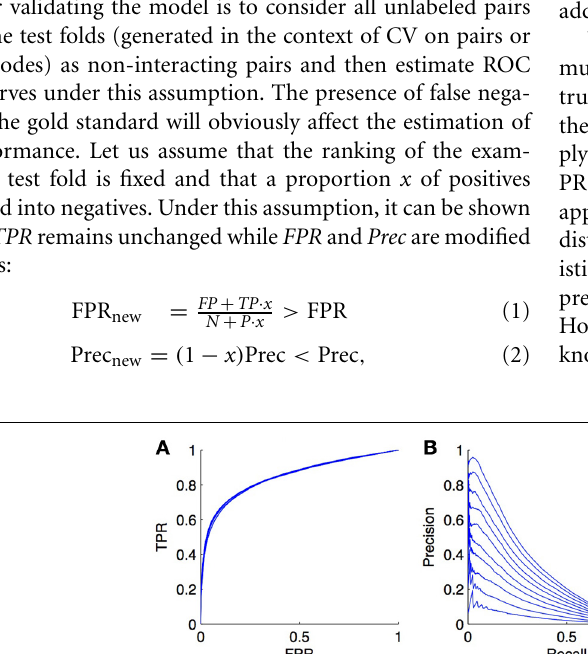
increases. The ratio varies from 0 to 0.9. Curves (C) show the evolution of the PR curve when the ratio P / N is set similarly as in (B) . Although the PR curve degrades also in this case, the degradation is not as important as when false negatives are introduced.